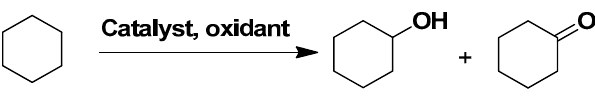
Scheme 1. General scheme of cyclohexane